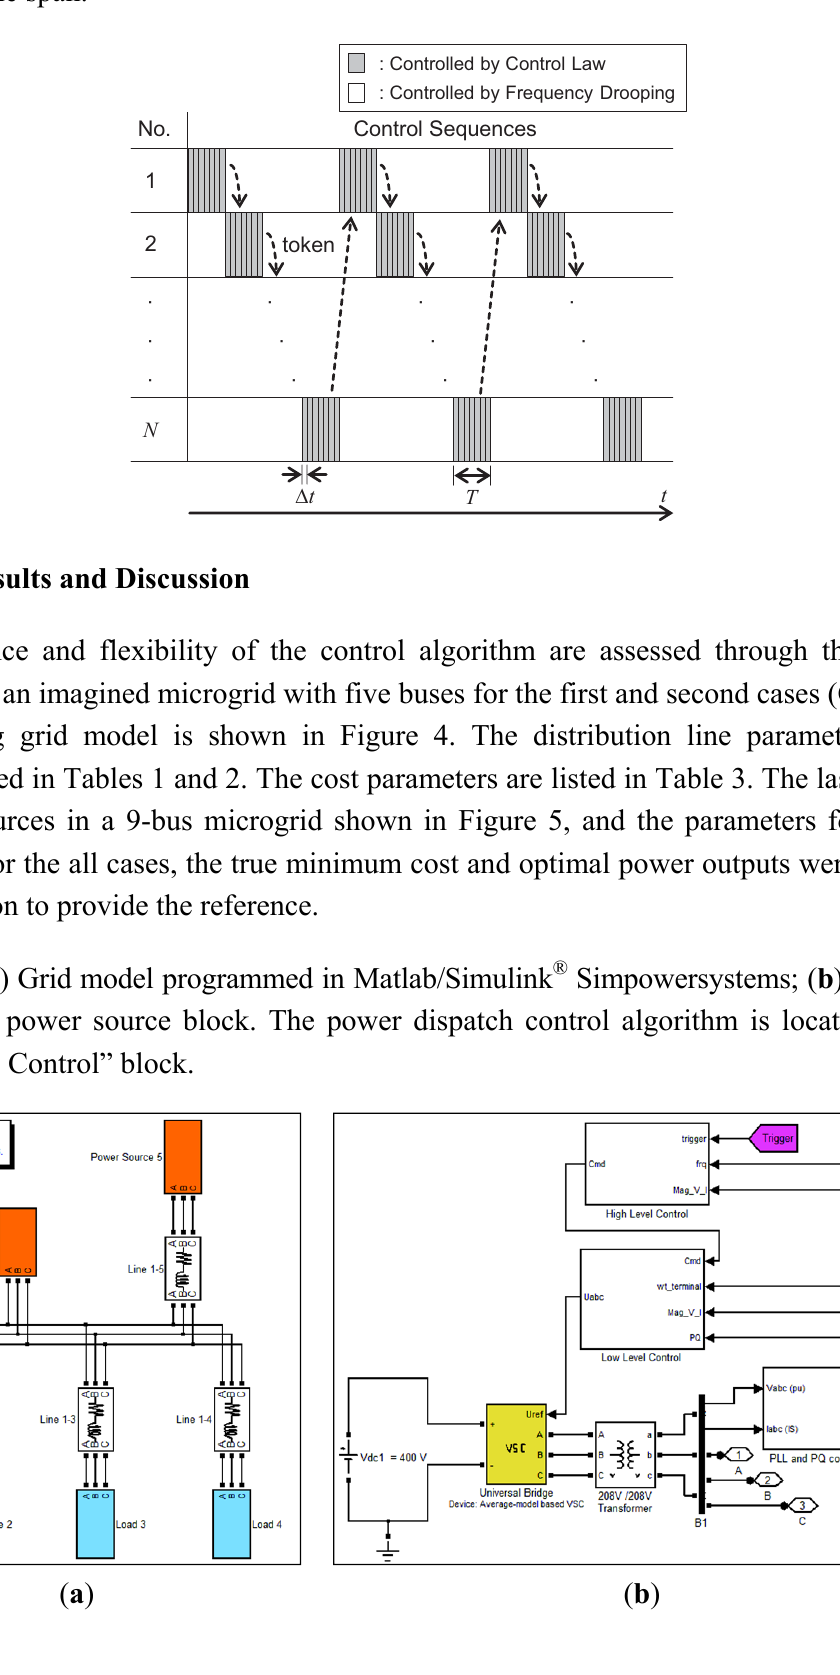
Figure 3. Conceptual control sequences of the decentralized control algorithm. Note that, at each time step, only one power source is controlled by the control law Equation (14), and the other power sources are governed by frequency drooping. Δ t is a time step and T is a control time span.